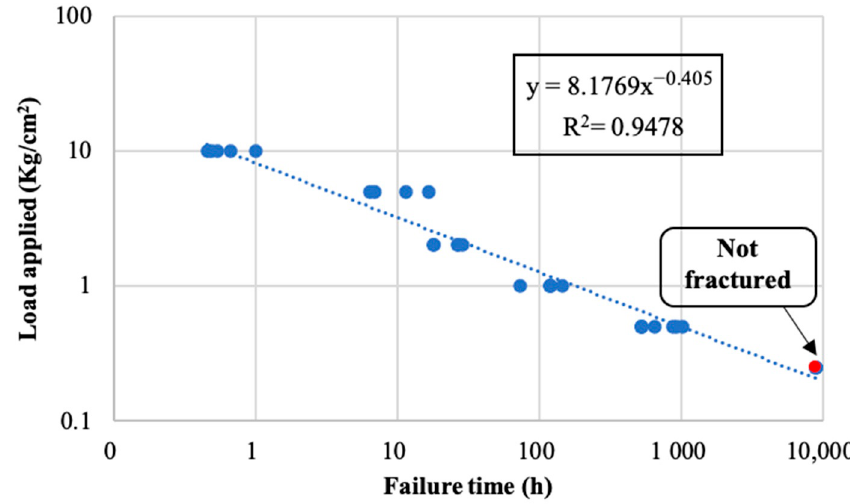
Figure 17. FF adhesive fracture time for the different loads applied.